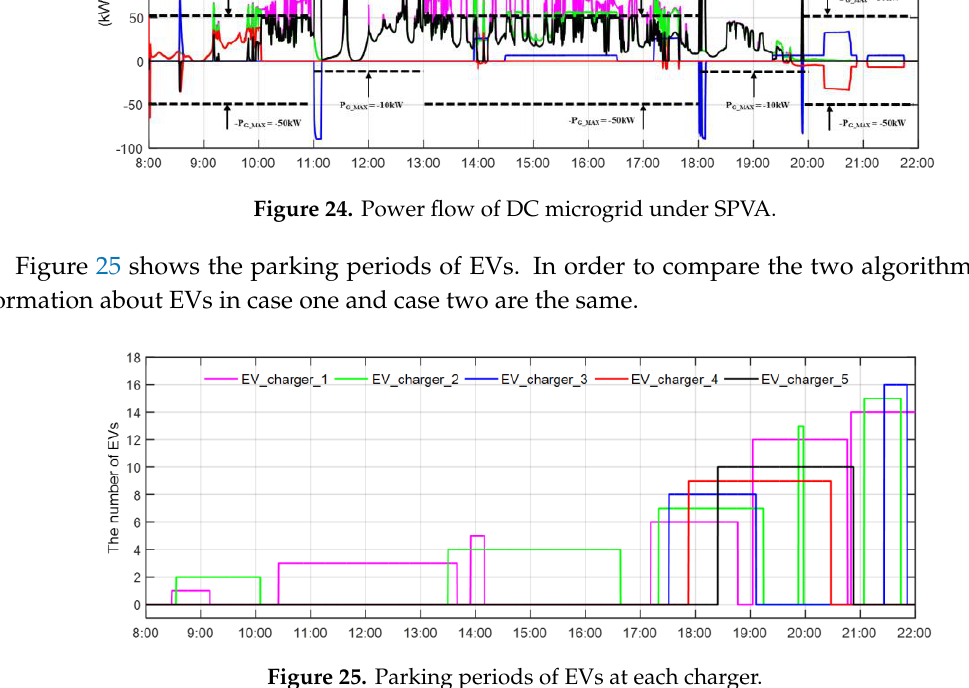
Figure 25. Parking periods of EVs at each charger.